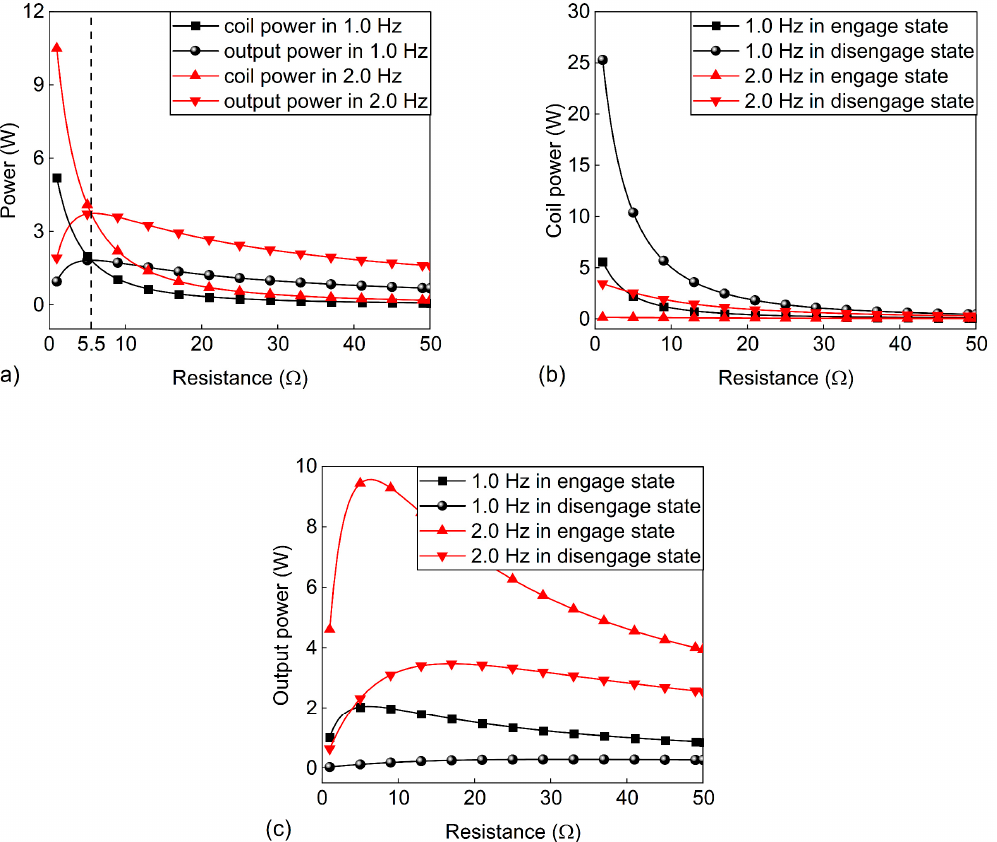
Figure 13. A generator consuming and harvesting power with different resistances (parameters of input: A = 20 mm). ( a ) Output power and coil power. ( b ) Coil power in the engagement state and disengagement state. ( c ) Output power in the engagement state and disengagement state. Table 3. Output electrical energy with different load resistances.